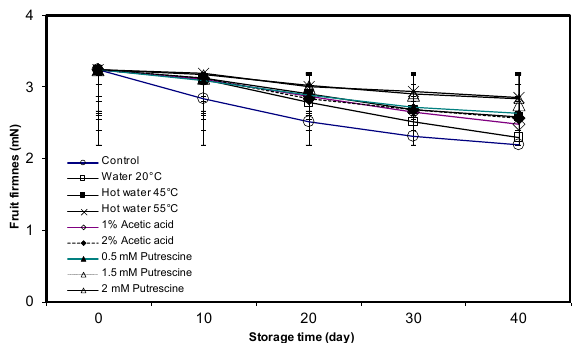
Figure 3. Mean firmness (± standard deviation; n = 3) of cv. Shah- rodi apricots before and during storage for 40 d at 5°C following different